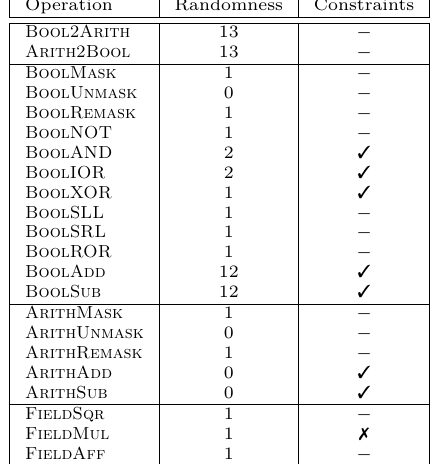
Table 4: For each masked underlying operation as implemented using the ISE, a description of a) the number of fresh masks used, and b) whether dependent inputs are allowed ( (cid:51) ), i.e., the ALU will apply any remasking required, disallowed ( (cid:55) ), i.e., the user must apply any remasking required, or not applicable ( − ), i.e., either 0 or 1 masked input(s) is